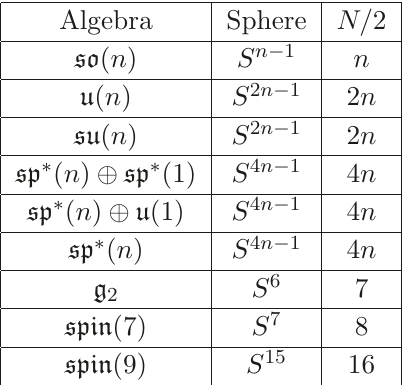
Table 1 . sp ∗ ( n ) is the compact symplectic algebra with (real) dimension n (2 n + 1) and a real form of sp (2 n